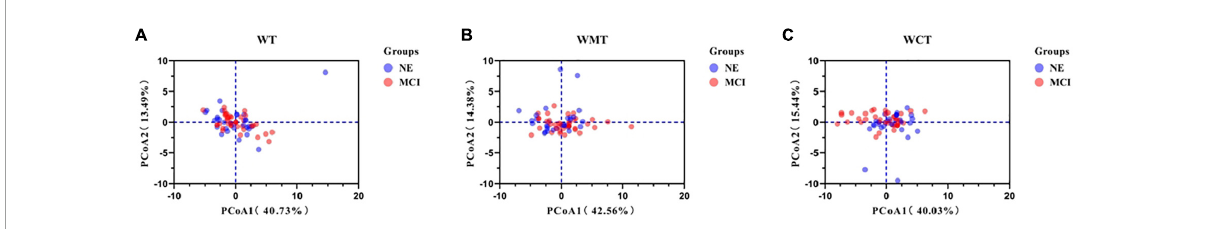
FIGURE2 Principal component analysis of spatial-temporal parameters. Component loading plot of spatial-temporal parameters for all 68 patients in three different tasks. (A) Walking task; (B) walking motor task; (C) walking calculate task. WT, walking task; WMT, walking motor task; WCT, walking calculate task; NE, normal elder; MCI, mild cognitive